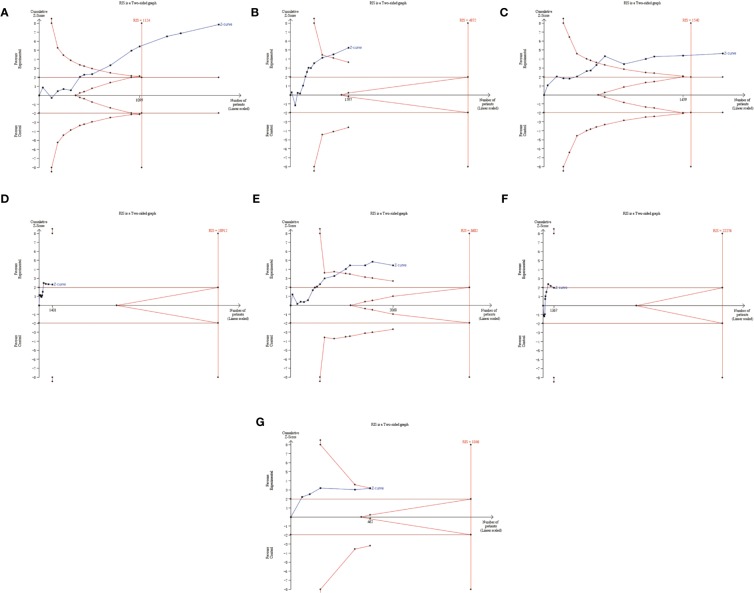
TSA plot for myelosuppression. (A) TSA plot for the decline of leukocyte counts (I–IV). (B) TSA plot for the decline of leukocyte counts (III–IV). (C) TSA plot for the decline of hemoglobin counts (I–IV). (D) TSA plot for the decline of hemoglobin counts (III–IV). (E) TSA plot for the decline of platelet counts (I–IV). (F) TSA plot for the decline of platelet counts (III–IV). (G) TSA plot for the decline of neutrophil counts (I–IV).